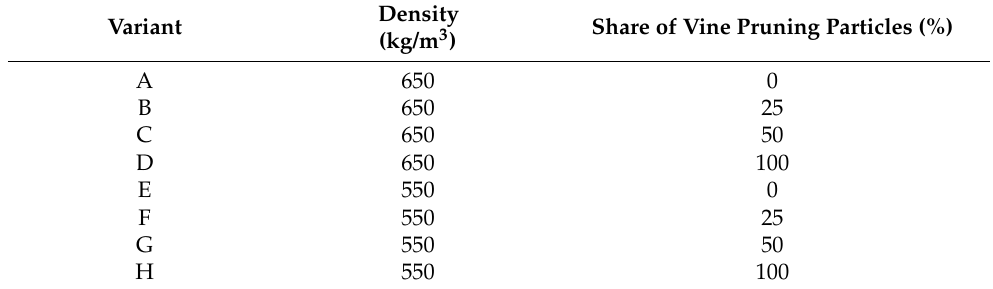
Table 3. Variants of manufactured